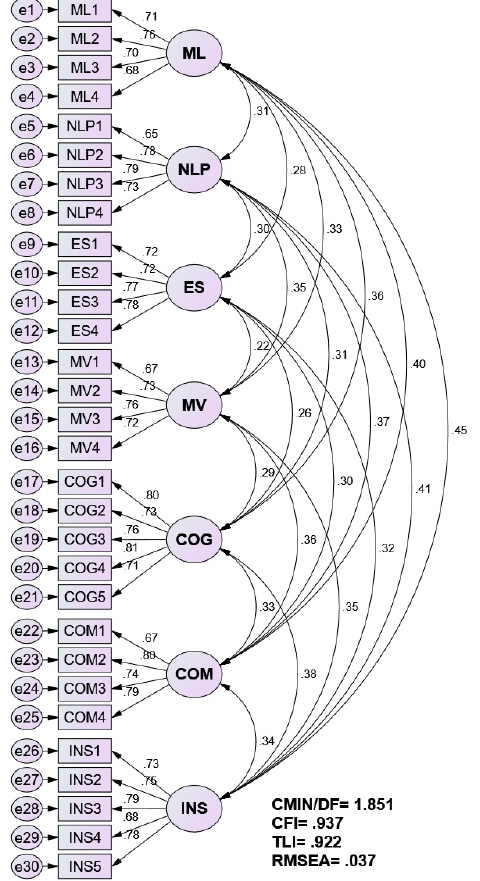
Fig. 2. Confirmatory factor analysis